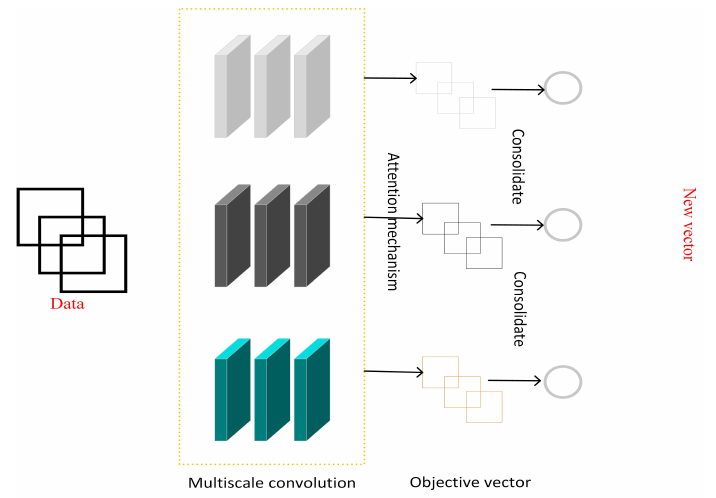
Figure 6. Multi-scale attention